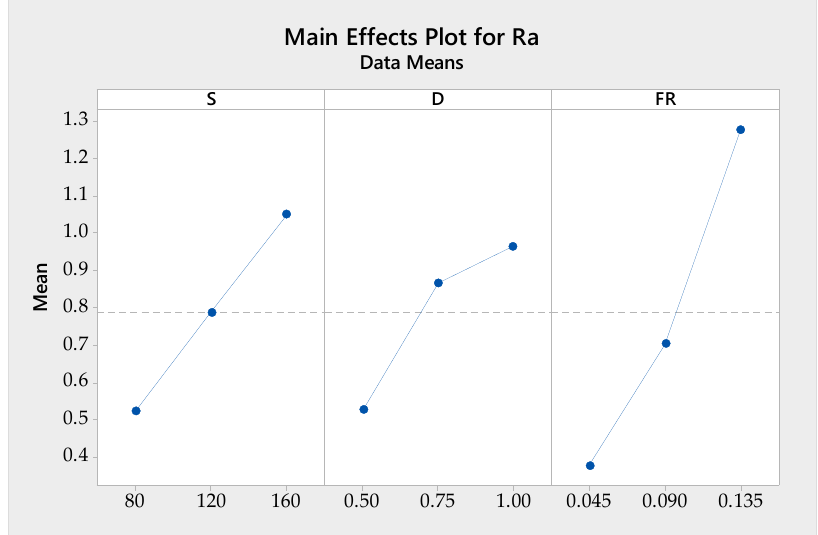
Figure 13. Main effect plots for Ra using wiper cutting edge.